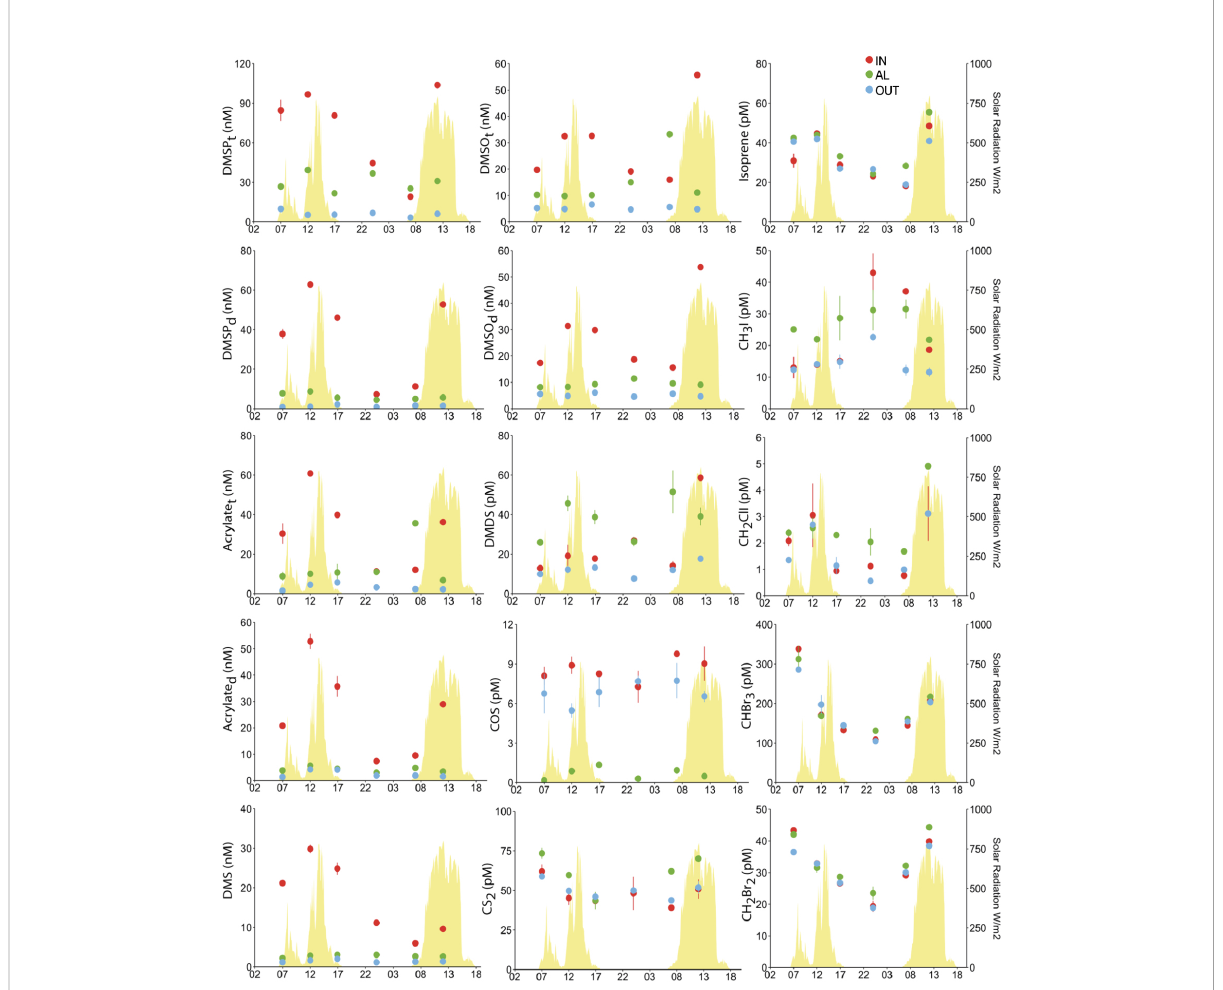
FIGURE 5 Total and dissolved DMSPC concentrations, and VOC concentrations around an Acropora pulchra colony over a diel cycle. Seawater samples were taken in the close vicinity of the living branch tips occupied by polyps (IN), the dead base of the branches, colonized by turf algae (AL), and 2 m away from the colony over a sandy bottom (OUT). Error bars denote the standard error of duplicate analyses. The yellow peaks in the background depict total solar